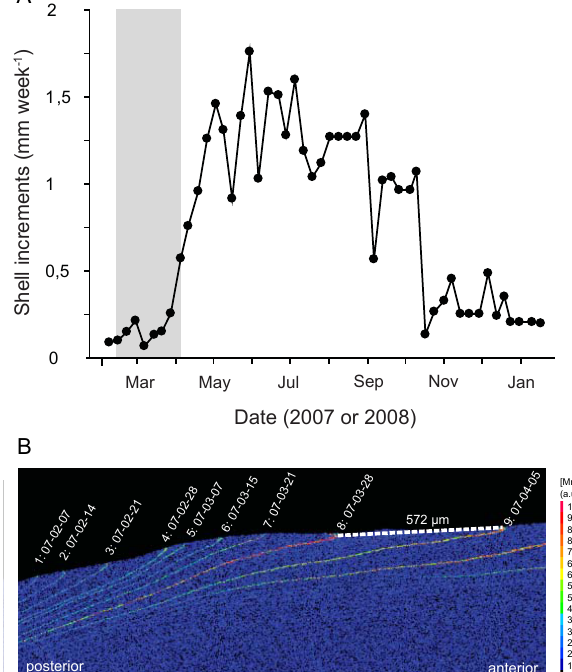
Fig. 2. Manganese marks in the calcite of the shell of a wild Mytilus edulis from Kiel Fjord illustrating weekly shell length growth be- tween 7 February 2007 (line 1) and 5 April 2008 (line 9). Shell [Mn 2 + ] in arbitrary units